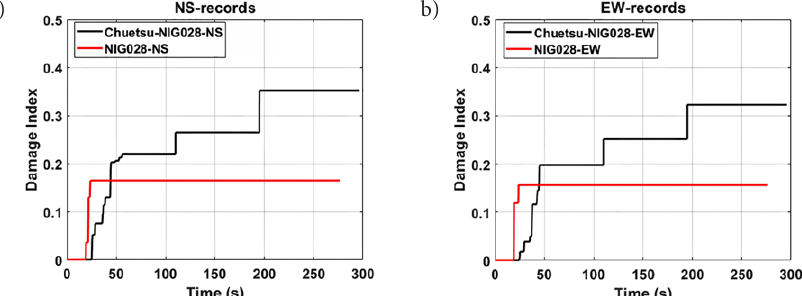
Figure 15. Damage index time-histories obtained under the NS and EW components of the Niigata records with and without sequences in the: a – transverse direction and b –